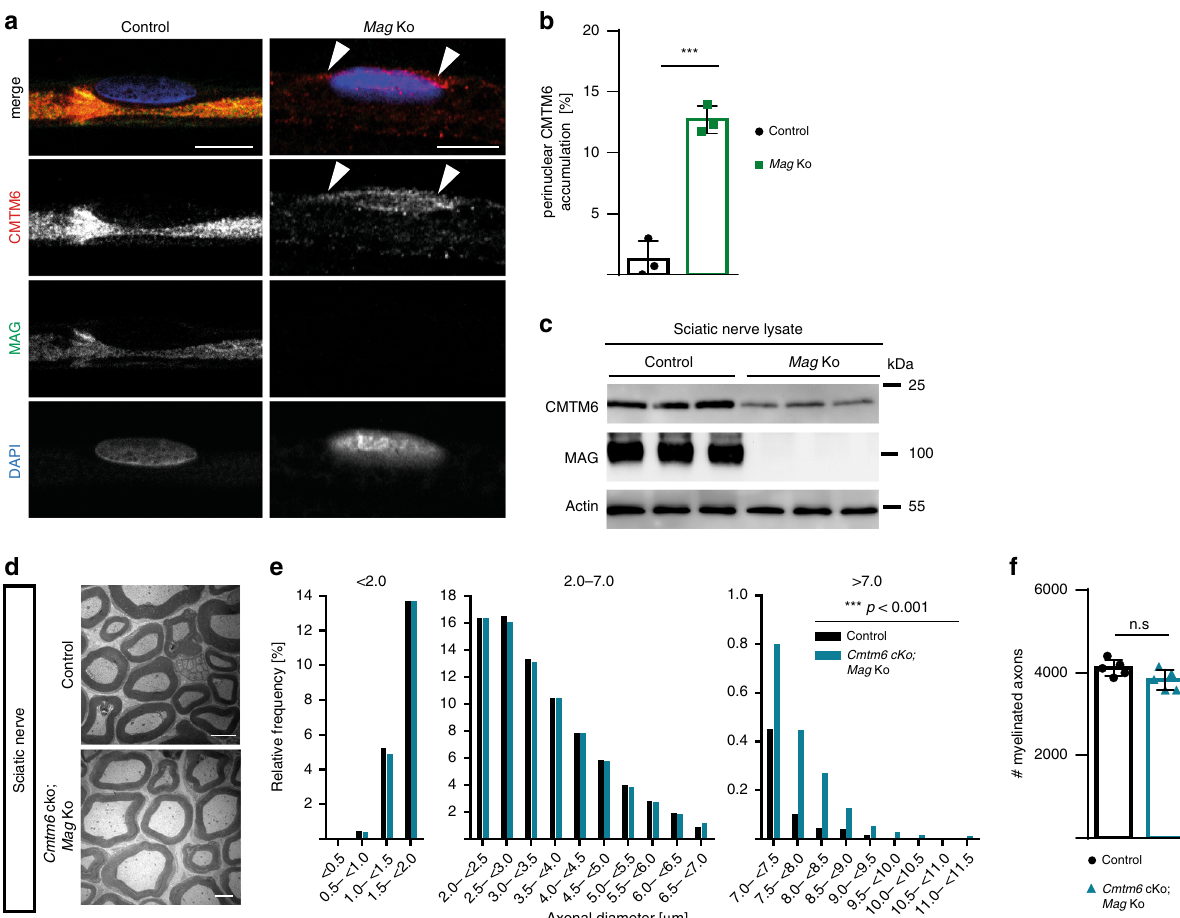
Fig. 5 Axonal diameters are increased in the absence of both CMTM6 and MAG. a , b Immunolabeling of teased fi ber preparations from sciatic nerves of 2-mo-old mice and genotype-dependent quanti fi cation reveals perinuclear accumulation of CMTM6 (red) when MAG (green) is lacking (indicated by white arrowheads). Nuclei were labeled with DAPI (blue). Scale bar, 10 µ m. n = 3 mice per genotype; P = 0.0005 by two-tailed Student ’ s t -test. c Immunoblotting shows decreased abundance of CMTM6 in Mag -Ko compared to control sciatic nerves at P75. Blots shows n = 3 mice per genotype. d Representative electron micrographs of cross-sectioned sciatic nerves show increased axonal diameters in the sciatic nerves of Cmtm6 -cKo; Mag -Ko double-knockout compared to control mice at 2 mo. Scale bar, 2.5 µ m. e Genotype-dependent quanti fi cation reveals frequency distribution shift toward increased diameters of myelinated axons in sciatic nerves of Cmtm6 -cKo; Mag -Ko double-knockout compared to control mice at 2 mo. Data are presented as frequency distribution with 0.5 µ m bin width; n = 19108 axons from n = 5 control mice and n = 18003 axons from n = 5 Cmtm6 -cKo; Mag -Ko double- knockout mice; Mean axonal diameter (control + / − Cmtm6-cKo;Mag-Ko double-knockout) = 3.13 µ m + 0.09 µ m; P = 0.0001 by